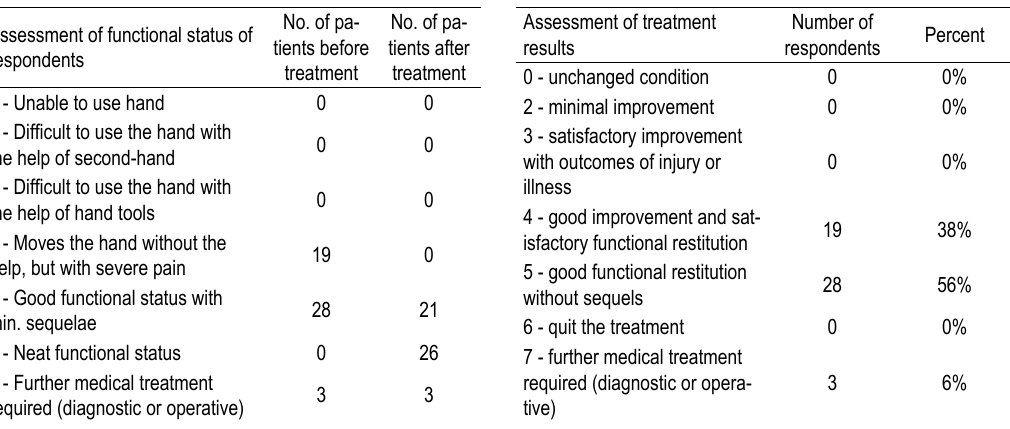
Table 5. functional status of respondents Table 6. results of